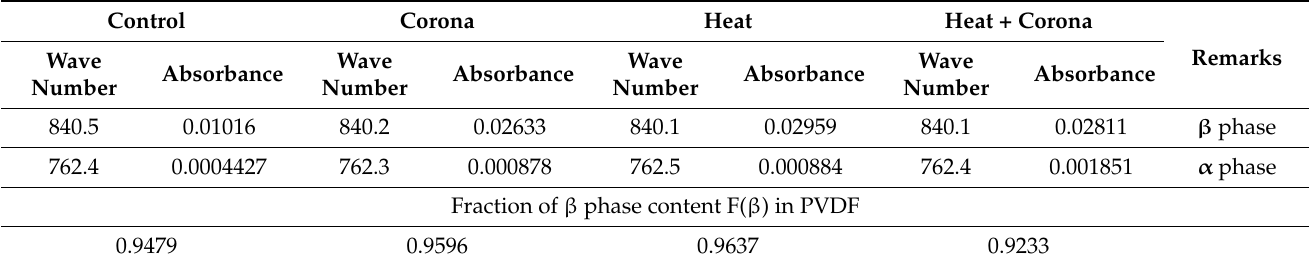
Figure 12. FTIR of MWCNT reinforced PVDF membrane. FTIR results of PVDF sample and MWCNT-reinforced PVDF sample is summarized in Table 2 and Table 3, respectively. Table 2. FTIR results and fraction of β phase formation in PVDF sample.